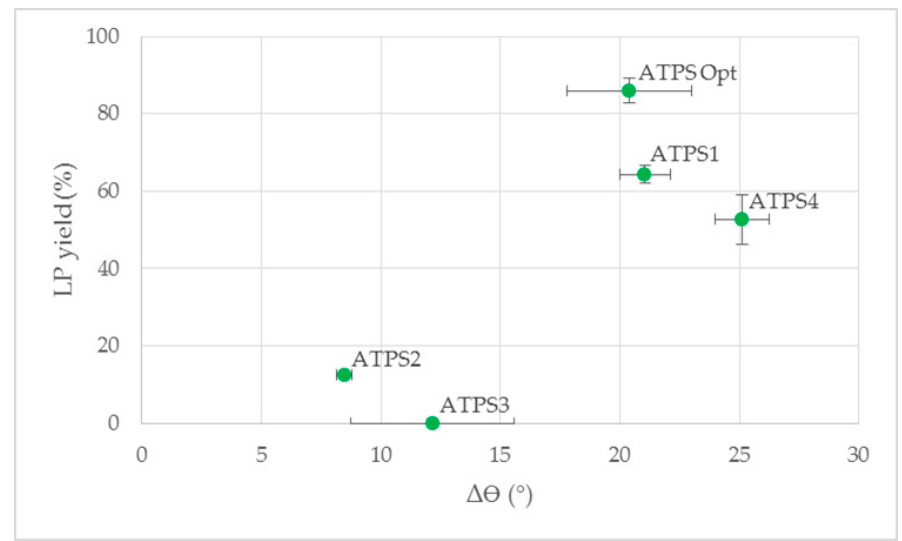
Figure 10. Yield of LP in the permeate until HP breakthrough with respective contact